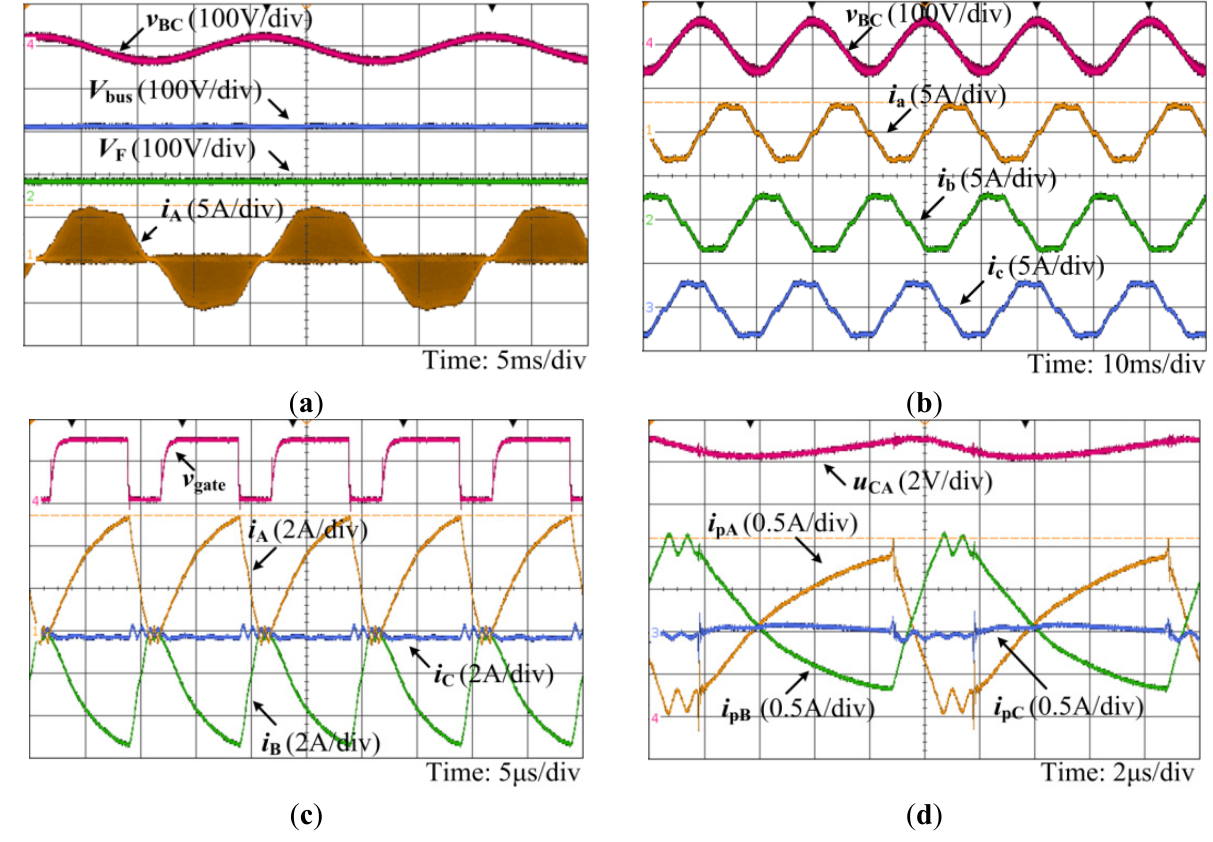
Figure 20. Experimental results at low input voltage. ( a ) input line voltage, output voltage and input current; ( b ) input line voltage and PMSM output currents; ( c ) gate signal and three phase input current in detail; ( d ) u CA and secondary currents of flyback